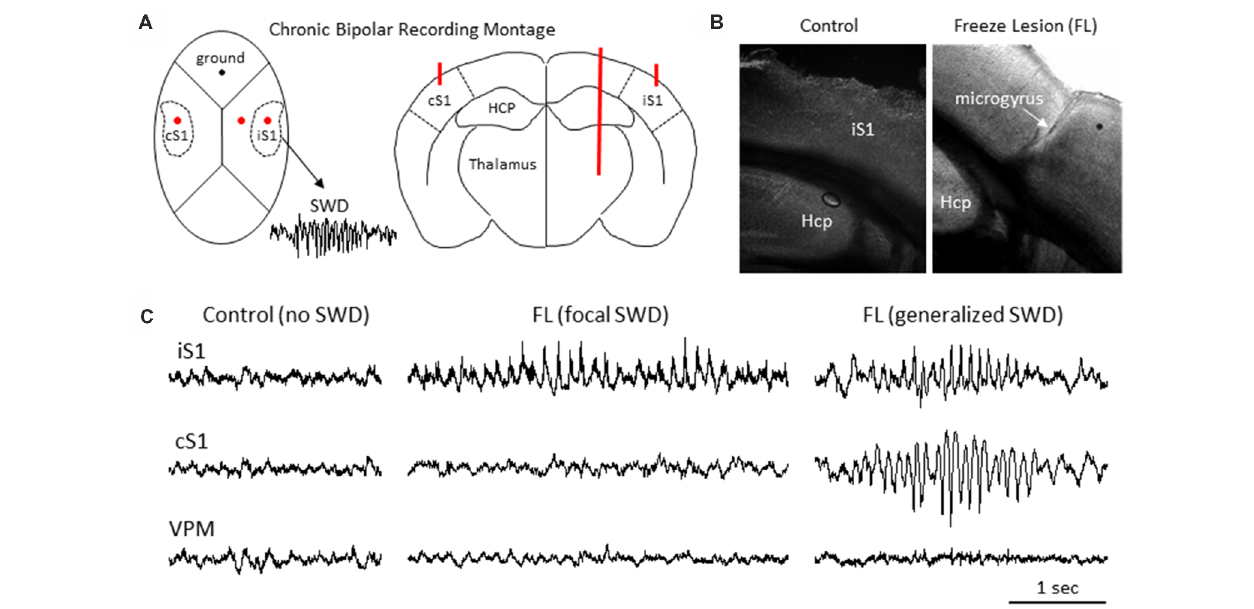
FIGURE 1 | Freeze lesion induced microgyrus and local field potential (LFP) recordings of spike-wave discharges (SWDs). (A) Diagram of mouse skull (left) and coronal brain section (right) indicating position of the chronic bipolar recording electrodes in the ipsilateral S1 (iS1), contralateral S1 (cS1) and thalamus. HCP, hippocampus. (B) Representative coronal section from the S1 cortical region of a control and FL mouse brain. (C) Examples of focal and generalized SWDs from FL animals that were generally confined to cortical regions and not observed in control animals.